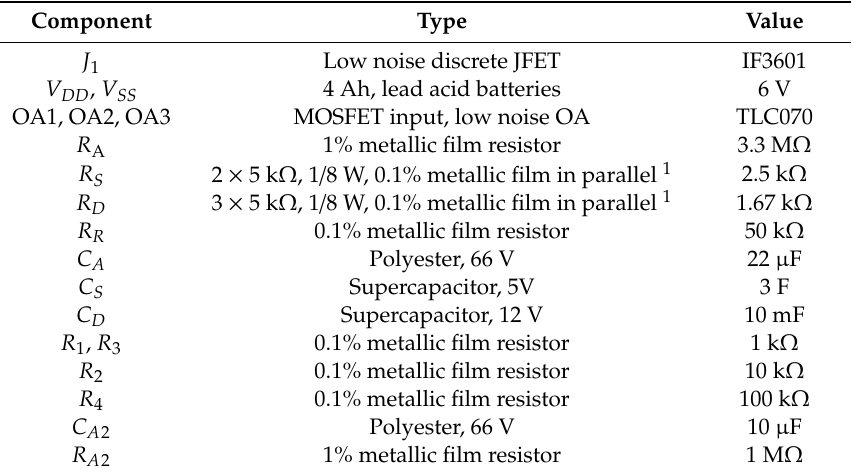
Figure 4. Detailed schematic of the low noise amplifier ( A 1 ) together with the two identical auxiliary amplifiers ( A 2 , A 3 ) required for gain calibration by means of cross correlation measurements. The detailed component list is reported in Table 1. Table 1. List for the circuit in Figure. 3.